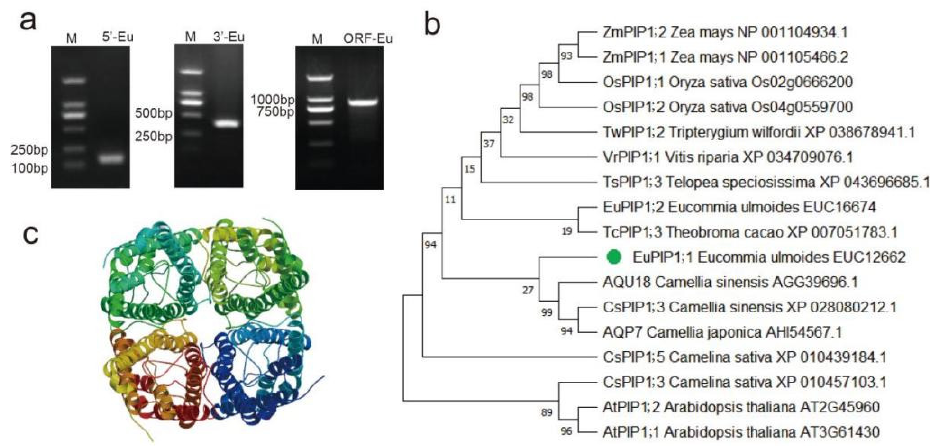
Figure 1. Amplification of EuPIP1;1 by RACE, phylogenetic analysis and tertiary structure of EuPIP1;1 . ( a ) Amplification of EuPIP1;1 by RACE. M: DL2000 marker, 3’-Eu: 3’UTR of EuPIP1;1 , 5’-Eu: 5’UTR of EuPIP1;1 , ORF-Eu: the full-length cDNA of EuPIP1;1 . ( b ) Phylogenetic analysis of EuPIP1;1 with other PIP proteins. ( c ) Prediction of the tertiary structure of EuPIP1;1.